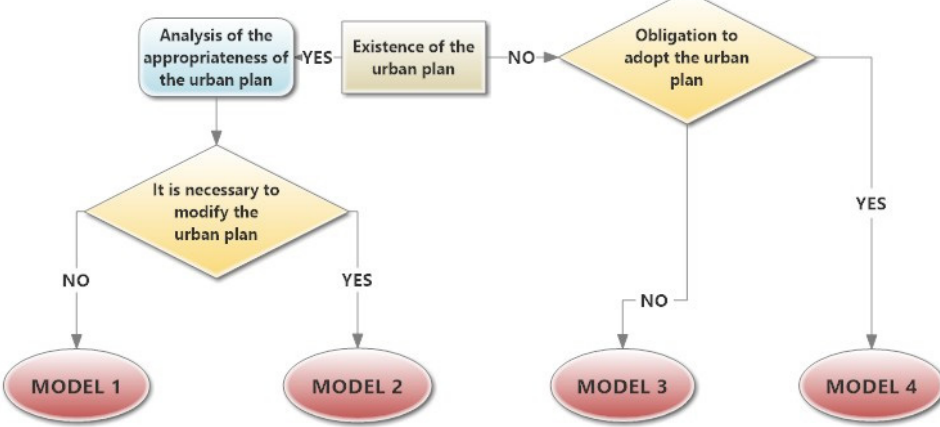
Figure 1. Flow chart of LR process depending on the existence and appropriateness of the urban plan.